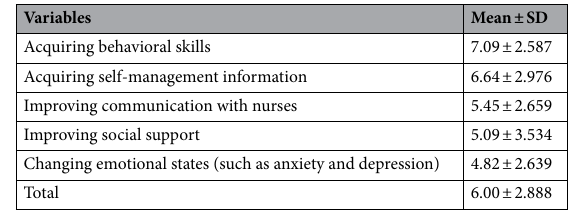
Table 2. Satisfaction with the